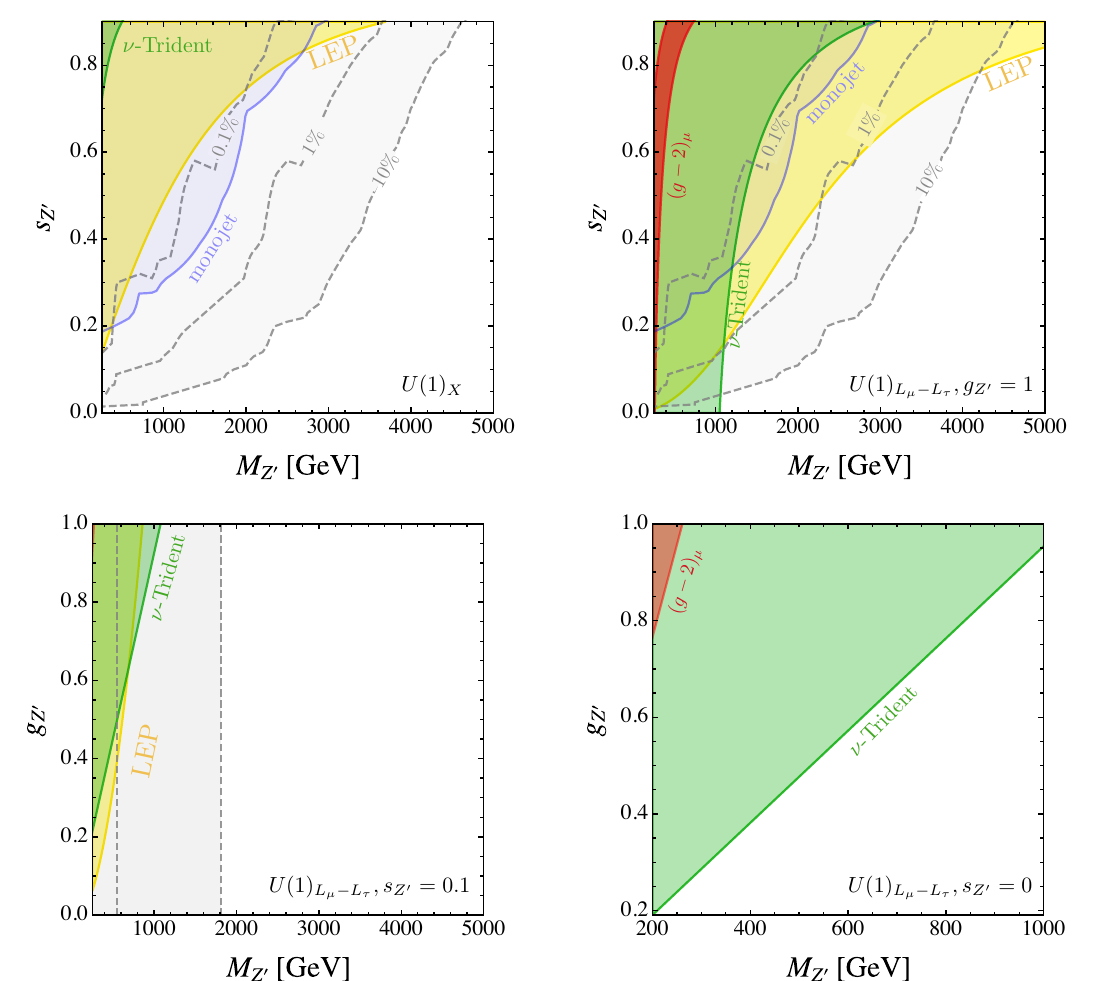
Figure 5: Bounds on the kinetic mixing angle s for a U ( 1 ) gauge boson (upper left) and a U ( 1 ) pling g X Z (cid:48) = 1 (upper right) or s = 0.1 (lower left) and s g Z (cid:48) Z (cid:48)